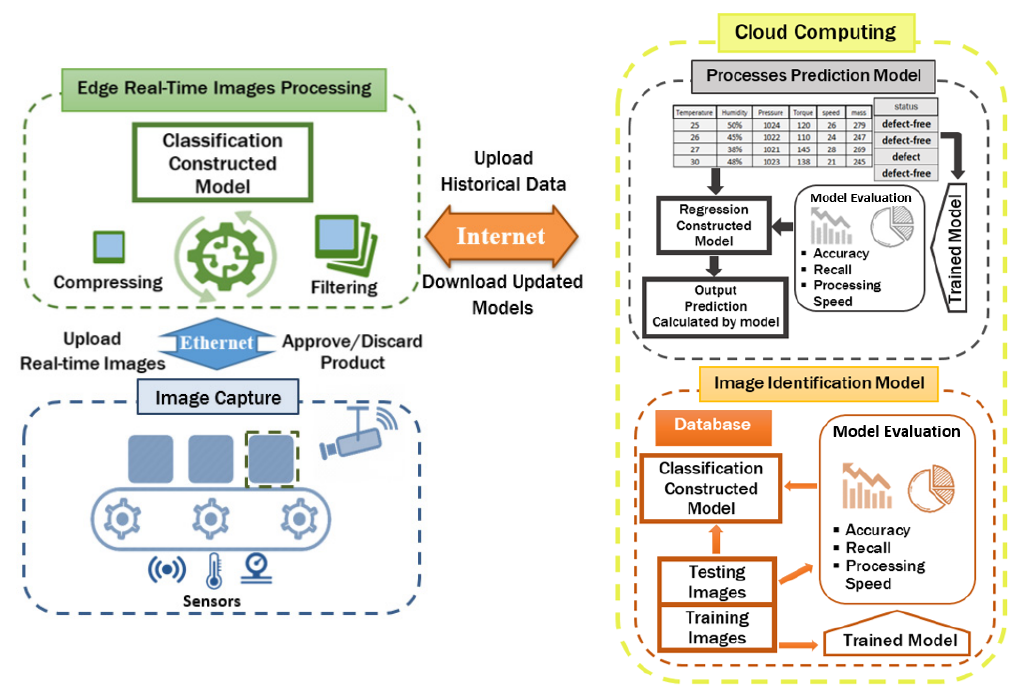
Figure 1. Intelligent machine vision model for defective product inspection.